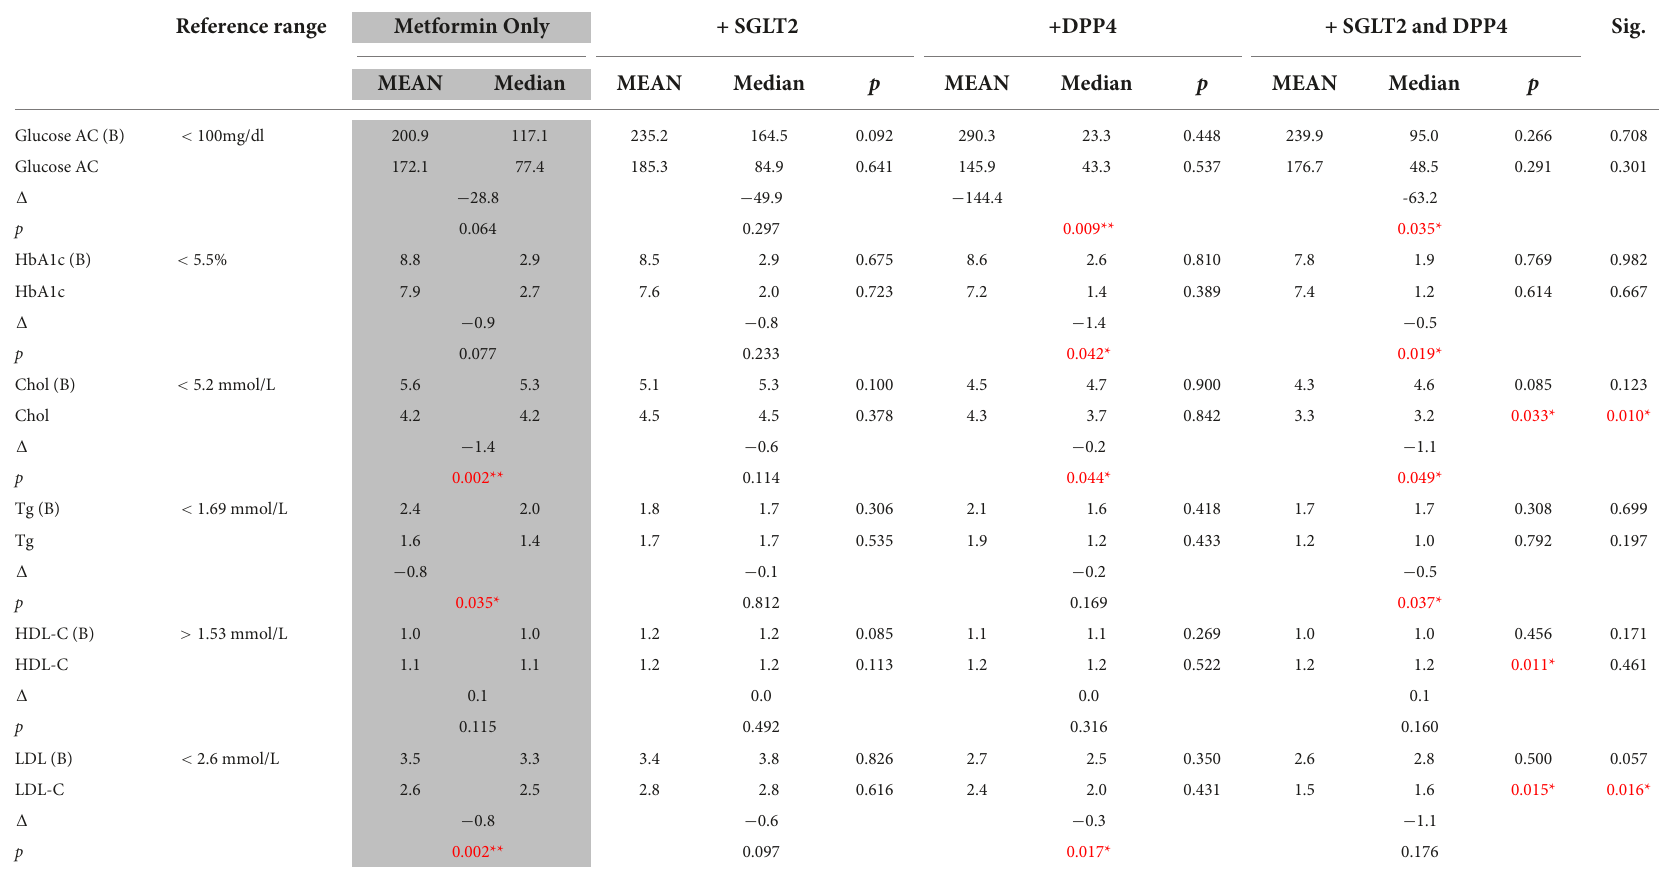
TABLE 2 Within-group analysis of glycemic control- and lipid profile-related biomarkers before and after treatment in each